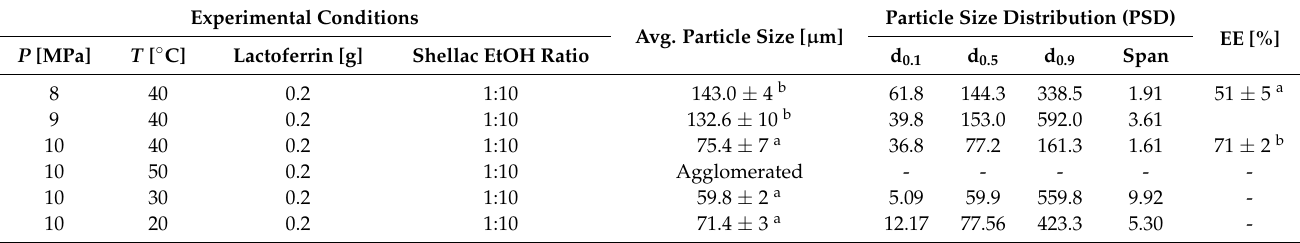
Here, d 0.5 refers to the median particle size; whereas d 0.1 and d 0.9 refer to the maximum particle diameter below which 10% and 90% of the sample volume exists, respectively; Span = d 0.9 − d 0.1 /d 0.5 . Mean values in the same column with different letters are significantly different at p <